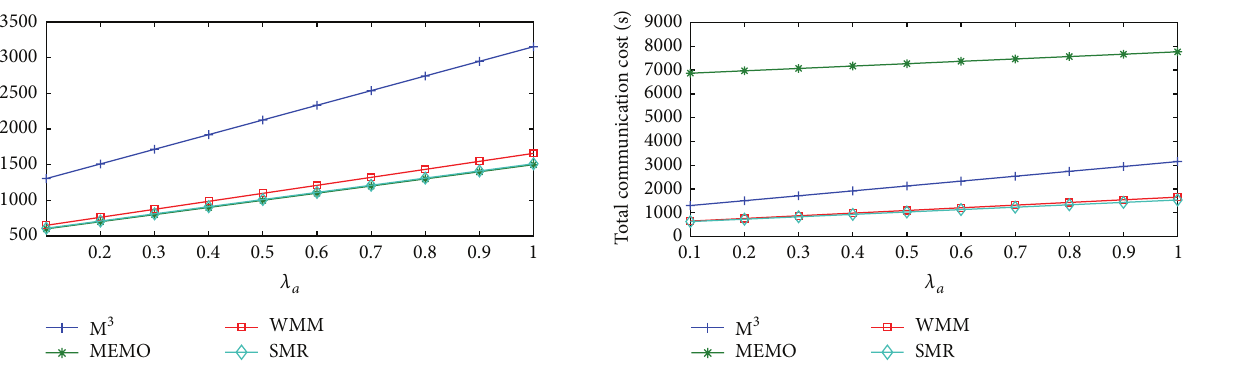
Figure 5: Packet delivery cost/sec versus 𝜆 𝑎 . Figure 6: Total communication cost/sec versus 𝜆 𝑎 .